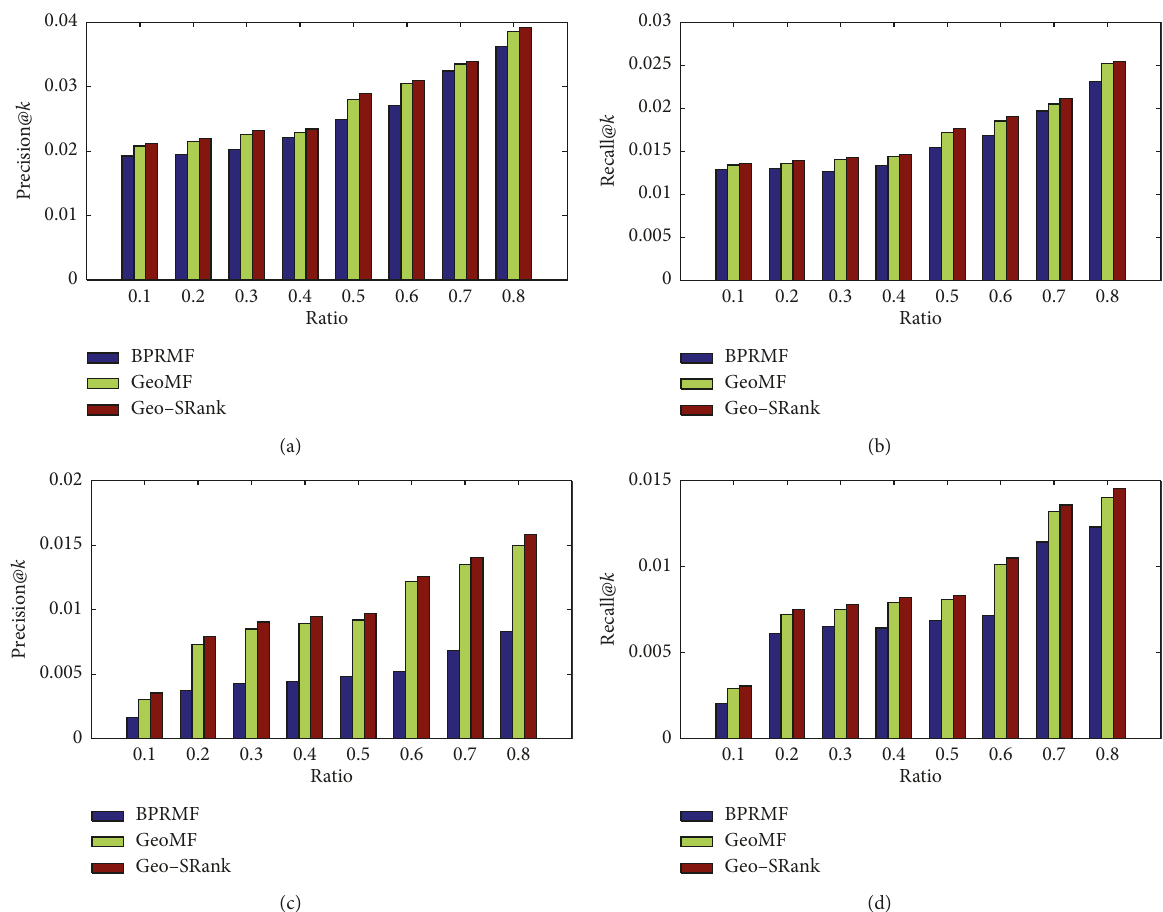
Figure 6: Experimental results with different training ratios ( k � 5). (a, b) Gowalla and (c, d)